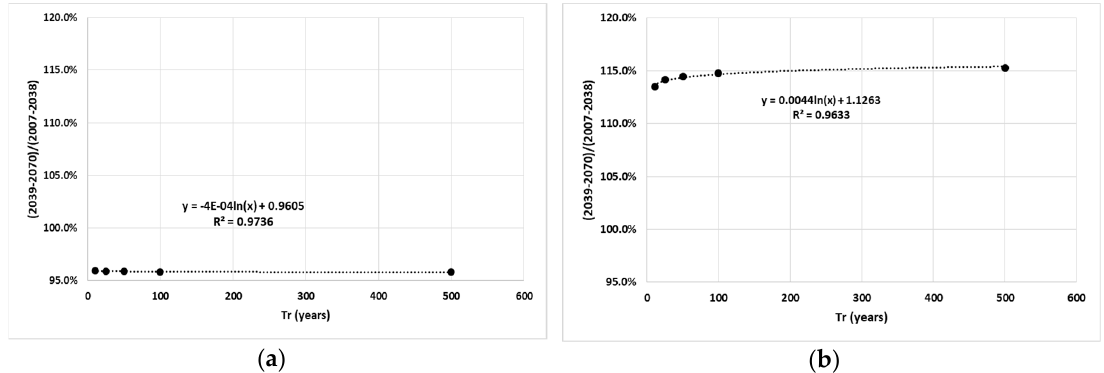
Figure 11. Flow rate projection ratio (2nd Stage (2039–2070)/1st Stage (2007–2038)) trend line in terms of return periods. ( a ) Analog method (ANA)—BCC-CSM1-1-m; ( b ) ANA—MRI-CGCM3.